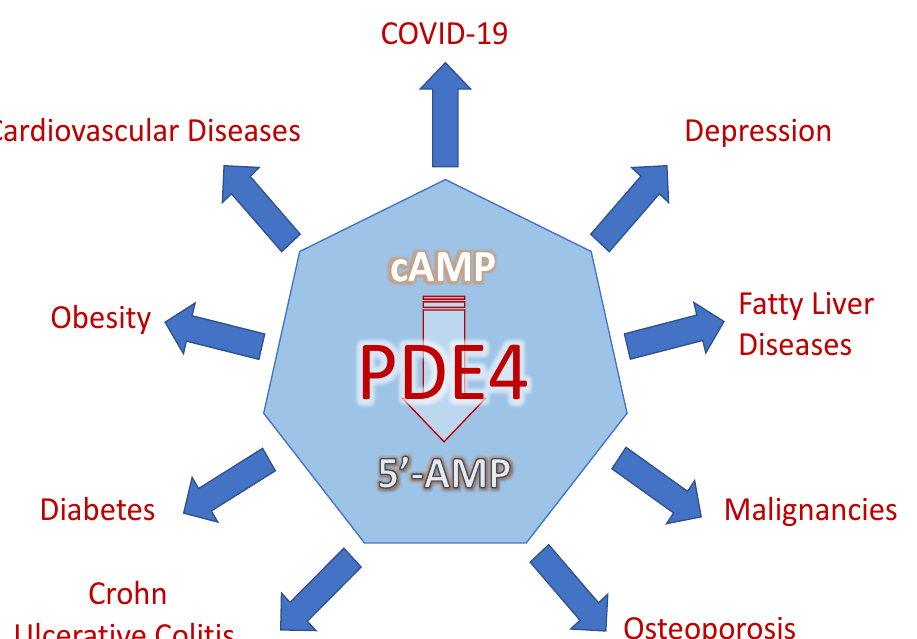
Figure 7. PDE4, a therapeutic target in various human diseases .